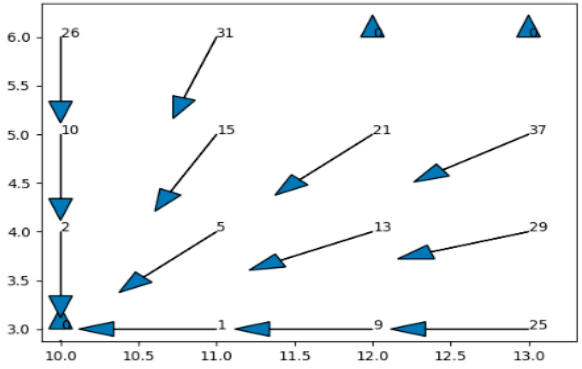
Figure 4. Computing global shortest distance of cell 37 from local neighbors: cells 13, 21, and 29.